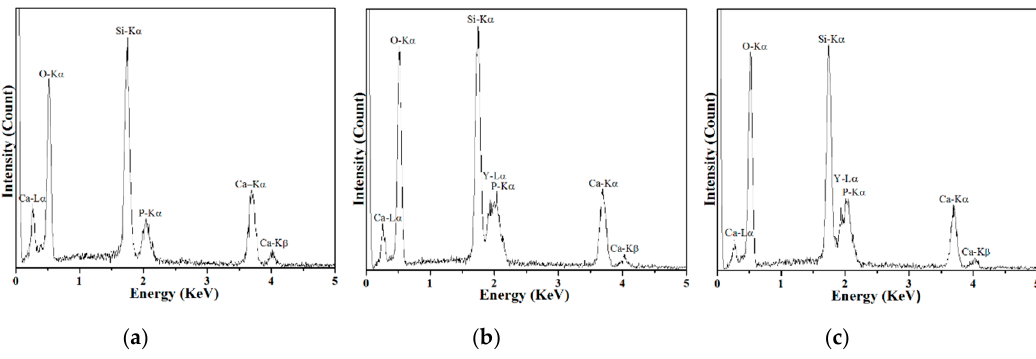
Figure 3. EDS spectra of ( a ) pure BG powder, ( b ) YAc, and ( c ) YN derived Y-doped BG powders.